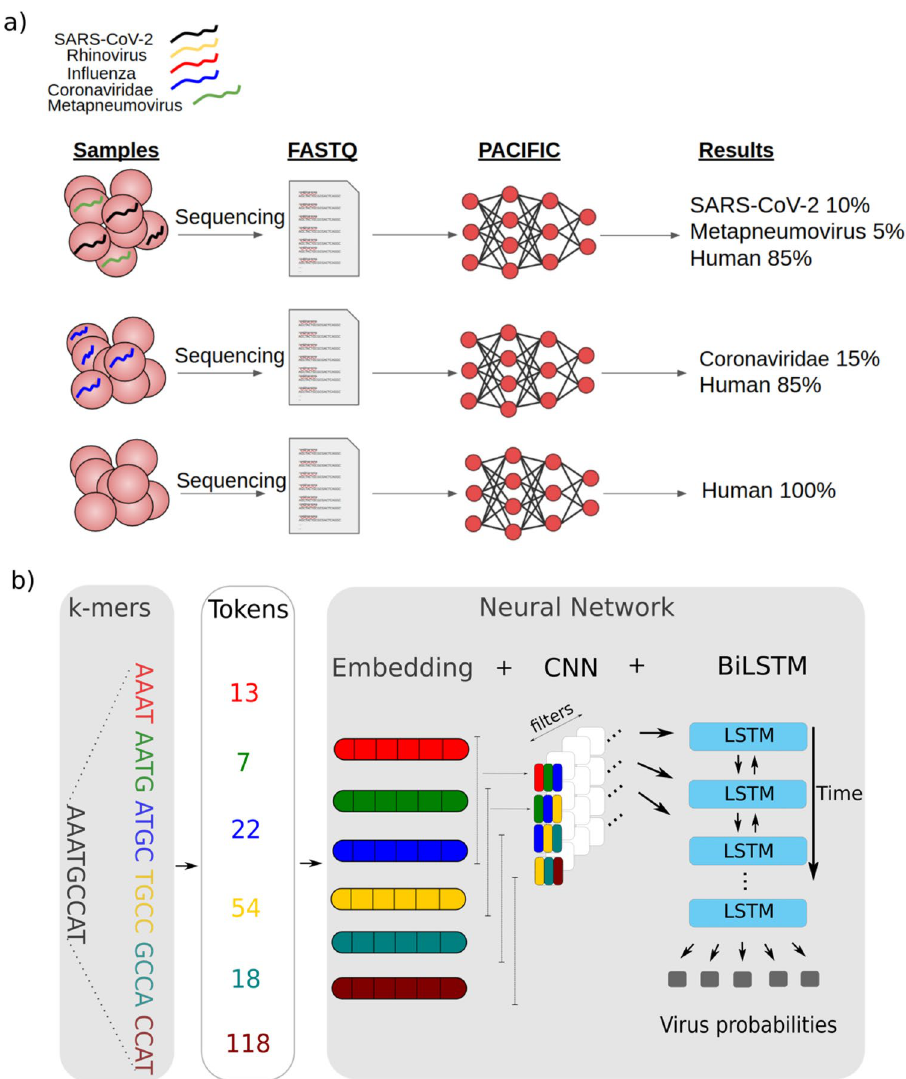
Figure 1. Overview of PACIFIC and its model architecture ( a ) PACIFIC uses FASTQ or FASTA files as inputs to make read-level predictions and to estimate the relative number of reads belonging to each RNA virus or human class. ( b ) PACIFIC deep neuronal network architecture, which includes embedding of k-mer tokens, convolutional neural network filtering to BiLSTM layers. The model is trained using in silico generated sequences from RNA virus genomes and the human transcriptome. CNN—convolutional neural network; BiLSTM—bi-directional long short-term